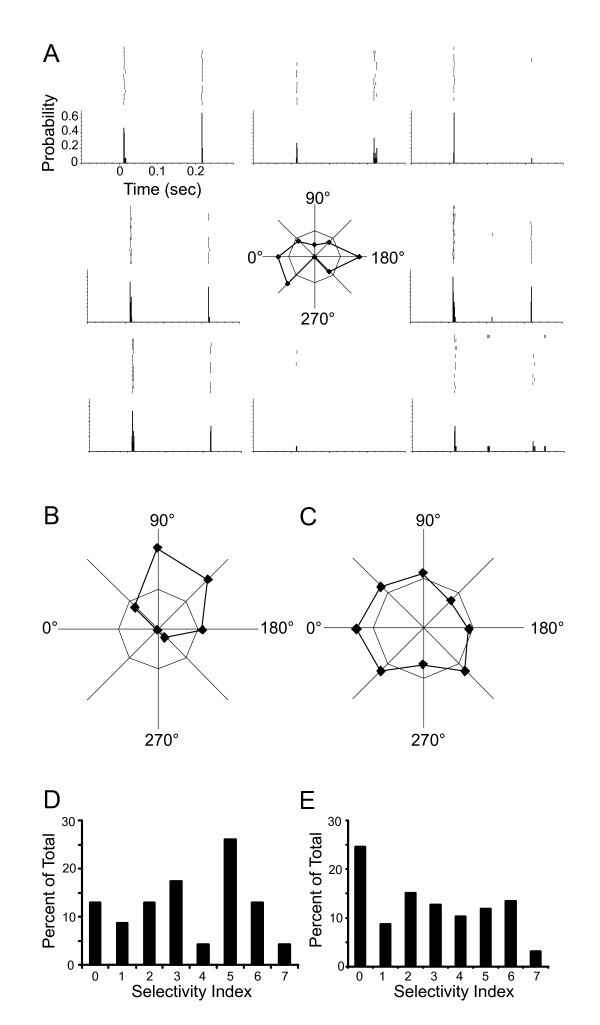
Superior colliculus neurons display a high degree of angular selectivity. A: To determine angular selectivity, vibrissae were deflected in eight directions. ON responses in each direction were used to compute the selectivity index (SI) and create the polar tuning curve (center). Distance from the center in the polar tuning curve represents the magnitude of the response for deflections in that direction. Octagon radii represent one spike/stimulus. B: A well-tuned neuron (SI = 5). C: A poorly tuned neuron (SI = 1). Histograms in D and E depict the SIs for all neurons tested, either considering only responses to the vibrissa evoking the largest response in each neuron (D); or considering all vibrissa-neuron pairs (E).